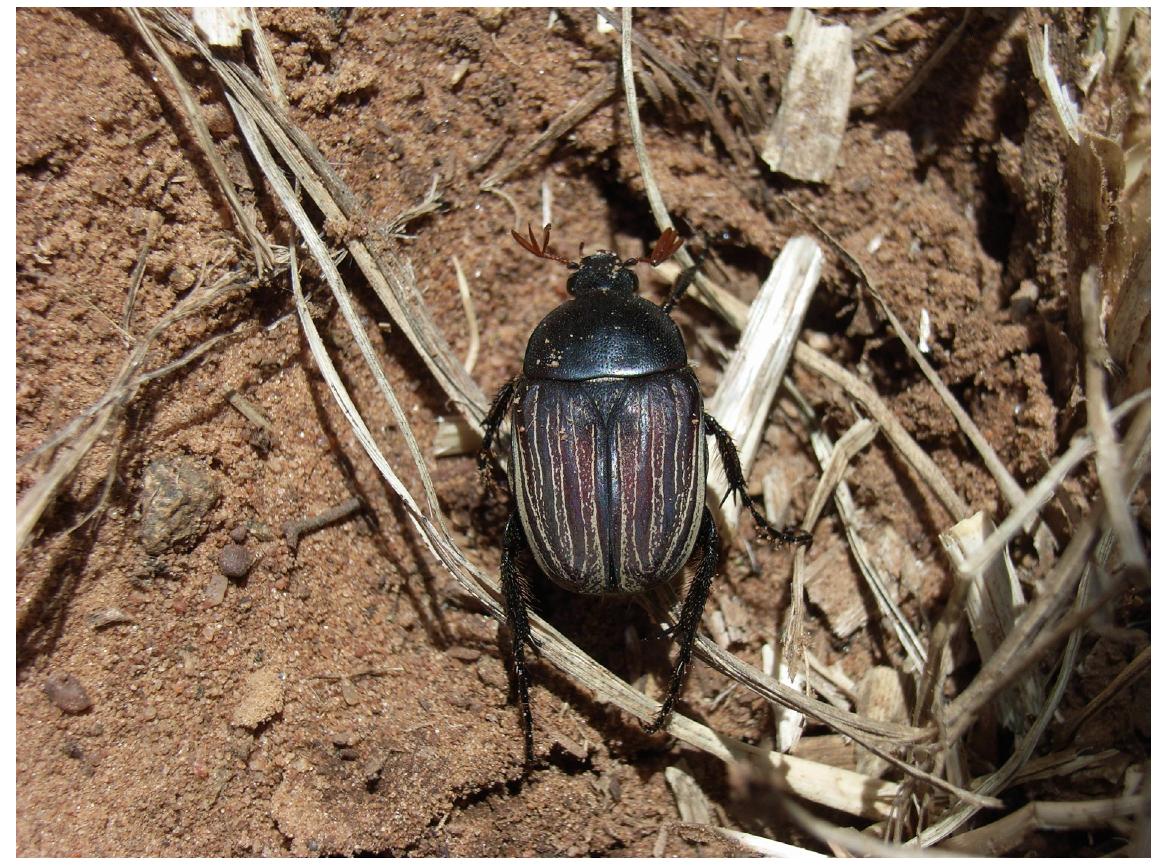
Fig. 4. Neoclita pringlei gen. et sp. nov., ♂, specimen in its natural habitat (photo: Lynette Clennell, Matatiele, 6 Dec.